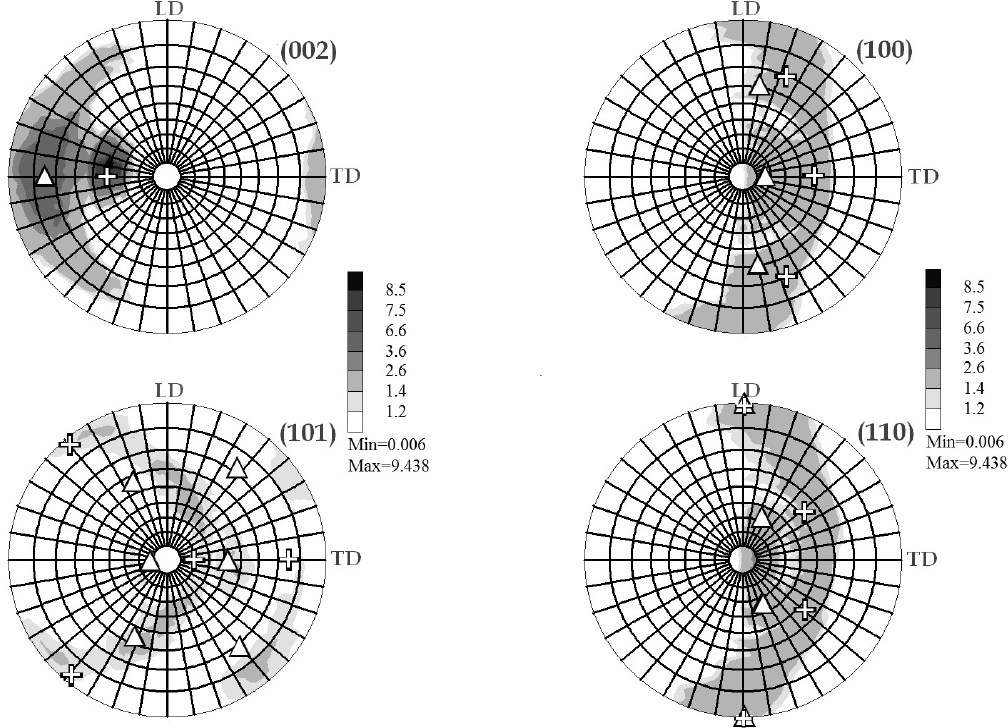
Figure 17. Stereographic projections of pole figures for the planes: (002), (100), (101), and (110).